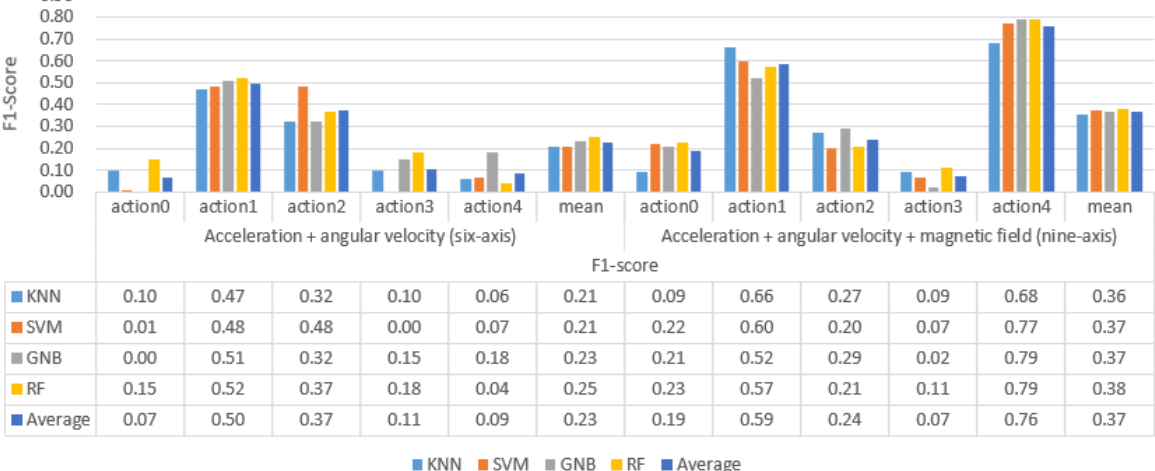
Figure 12. The recognition accuracy of traditional machine learning models based on artificial features on non-professional test sets.